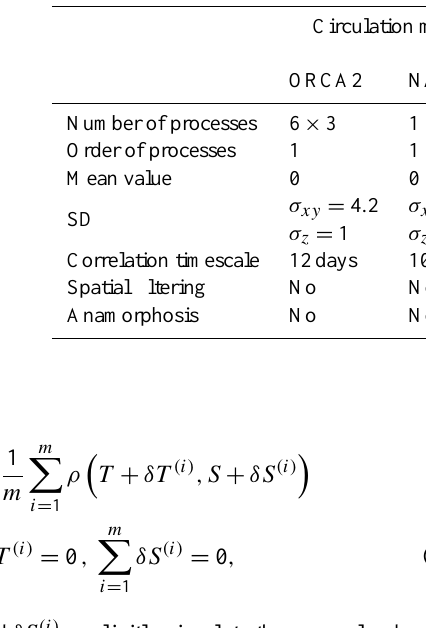
Table 1. Parameters of autoregressive processes for all applications described in this paper. The number of processes is the number of autoregressive processes used in each stochastic parameterization (sometimes multiplied by 3 to produce one process for each component of the random walks). The mean, SD and correlation timescale are the parameters µ (i) , σ (i) and τ (i) used in Eqs. (2) and (3). For the stochastic parameterization of the equation of state (circulation model), the SD values are multiplied by sin φ for ORCA2, and by sin 2 φ for NATL025, where φ is